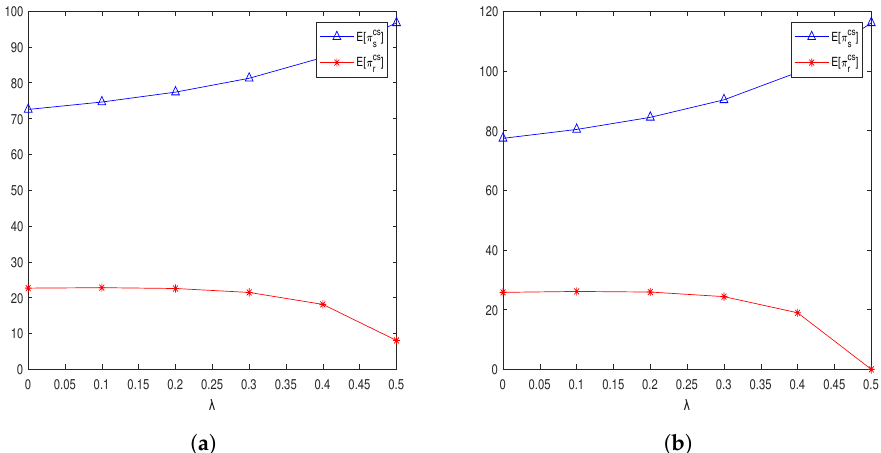
Figure 5. Impact of the cost-sharing ratio λ on the equilibrium profits. ( a ) ρ s = 0.8; ( b ) ρ s =